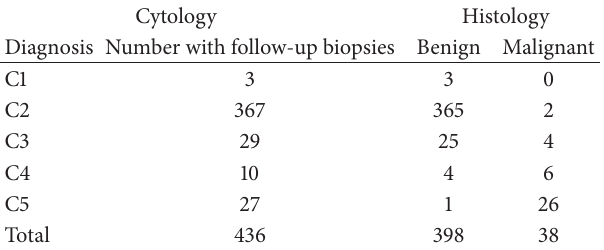
Table 1: Correlation of cytological and histological diagnosis.